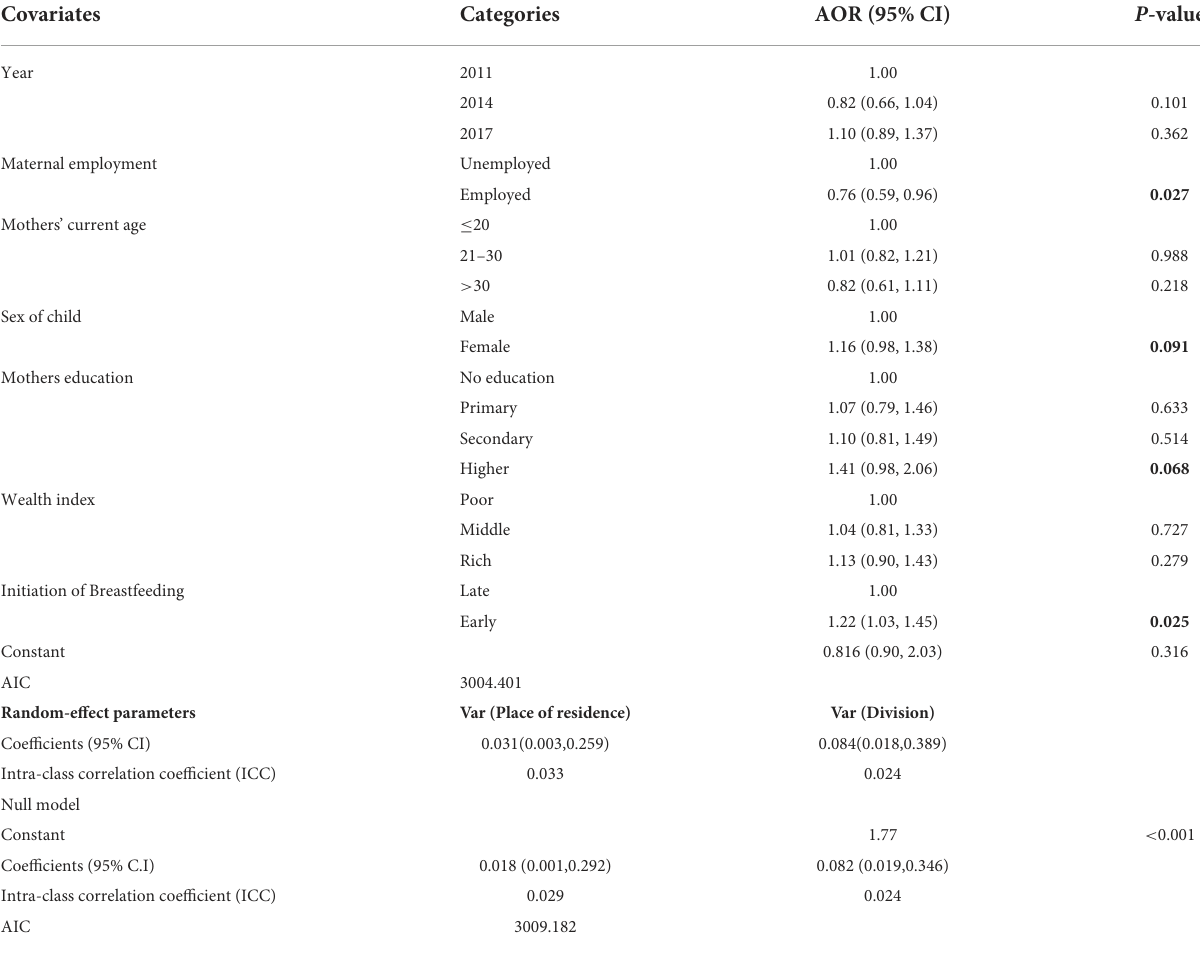
TABLE 3 Three-level logistic random intercept model using “place of residence” as level-two and “administrative division” as level-three factors to find the factors associated with exclusive breastfeeding (EBF) practice in Bangladesh.